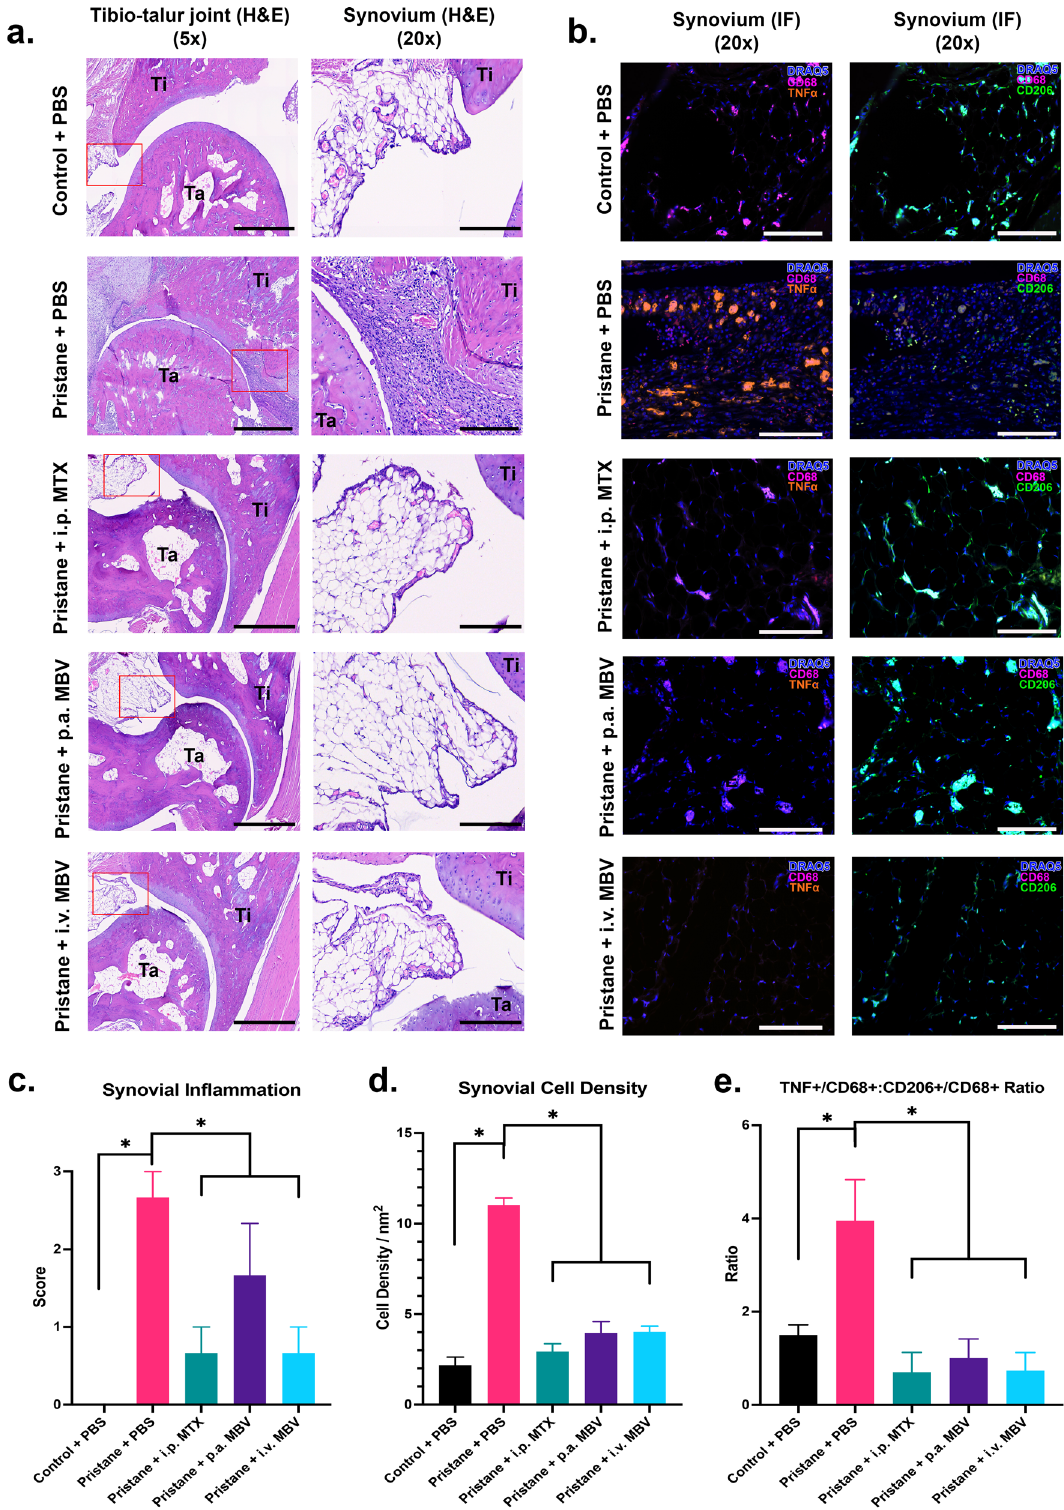
representative of an M2-like macrophage phenotype 5,6,10 – 13,16,42 . Preclinical and clinical studies have shown that ECM degradation products, including MBV, promote tissue regeneration and repair through the induction of an anti-in fl ammatory,